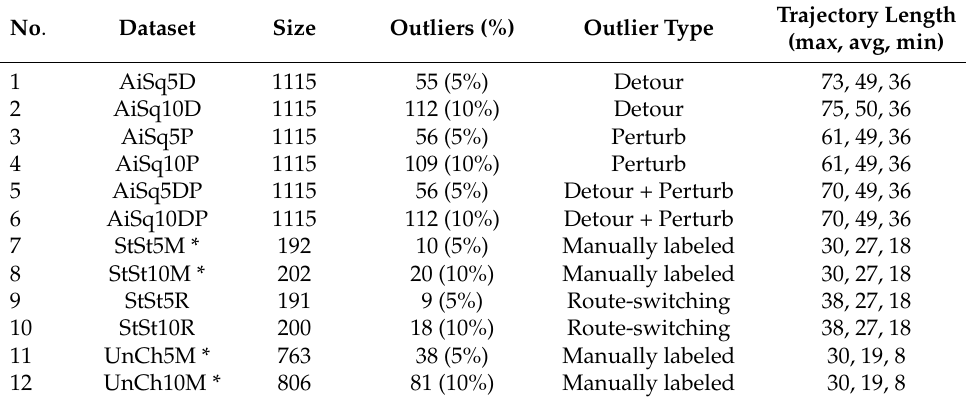
Table 1. Datasets with organic outliers marked with asterisk and injected